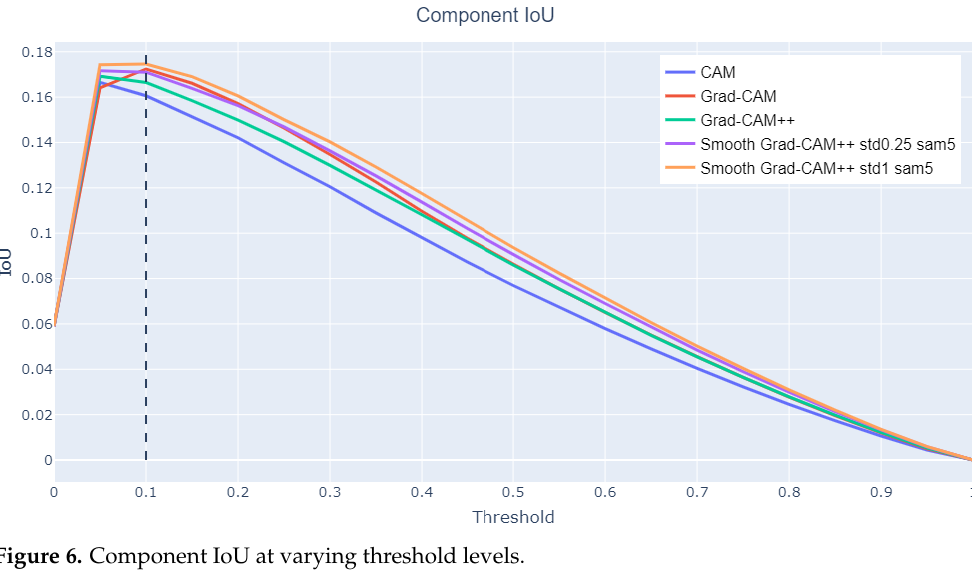
Figure 6. Component IoU at varying threshold levels.